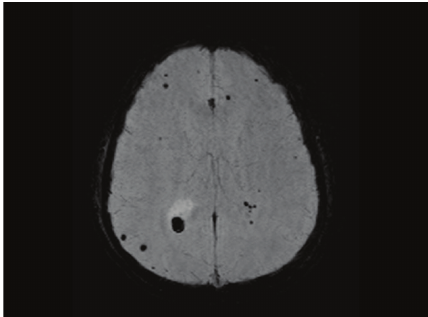
Figure 3: Axial susceptibility-weighted MRI image (TR-50; TE-40) showing multiple “dark” spots of magnetic susceptibility seen scattered in both cerebral hemispheres consistent with hemorrhagic brain metastasis.